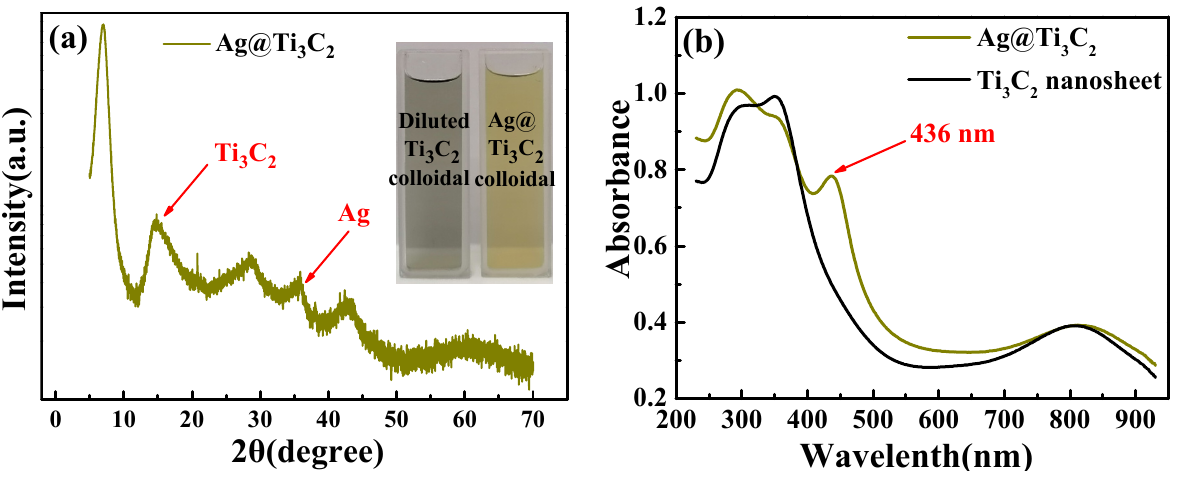
Figure 3. ( a ) XRD pattern of Ag@Ti 3 C 2 , ( b ) linear absorption spectra of Ag@Ti 3 C 2 and Ti 3 C 2 nanosheets.